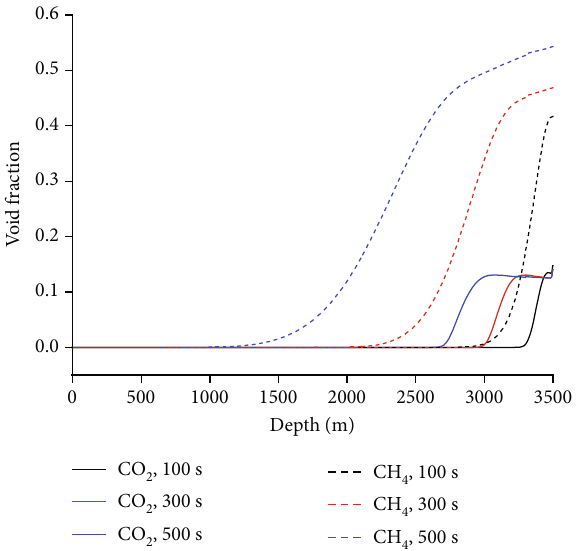
Figure 7: The pro fi les of dissolved gas along the wellbore during methane and CO 2